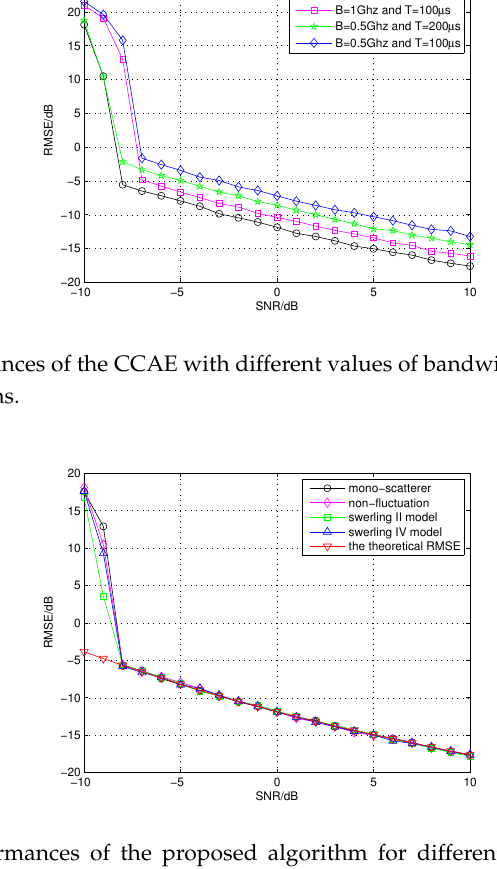
Figure 10. The performances of the proposed algorithm for different types of targets and the theoretical